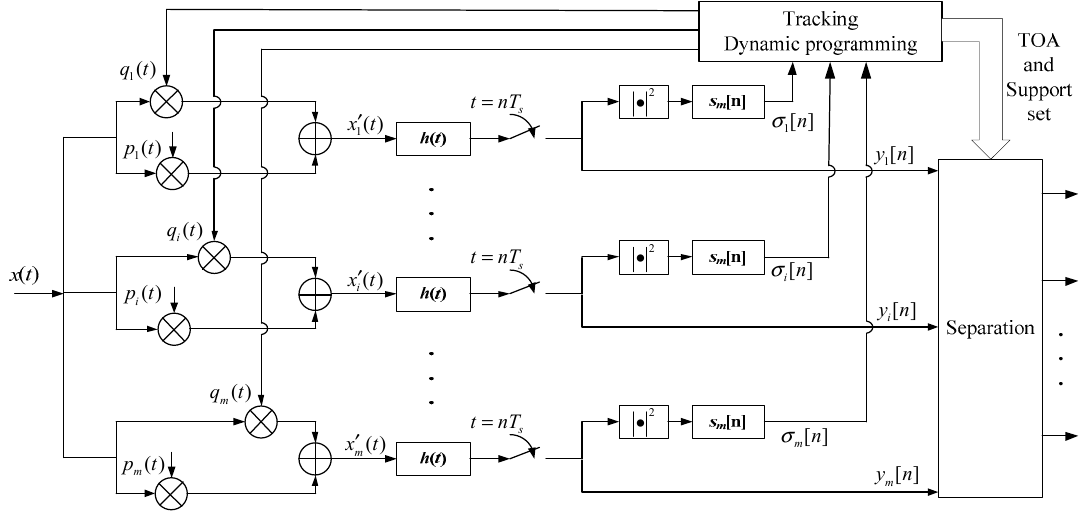
Figure 2. Dynamic programming modulated wideband converter (MWC) structure.